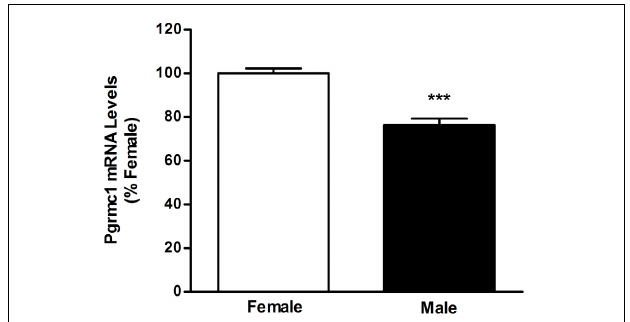
FIGURE 2 | Results of quantitative real-time polymerase chain reaction analyses measuring PGRMC1 mRNA in microdissections of postnatal day 2 female and male anteroventral periventricular nuclei. ∗∗∗ Significantly different from female; p < 0 .